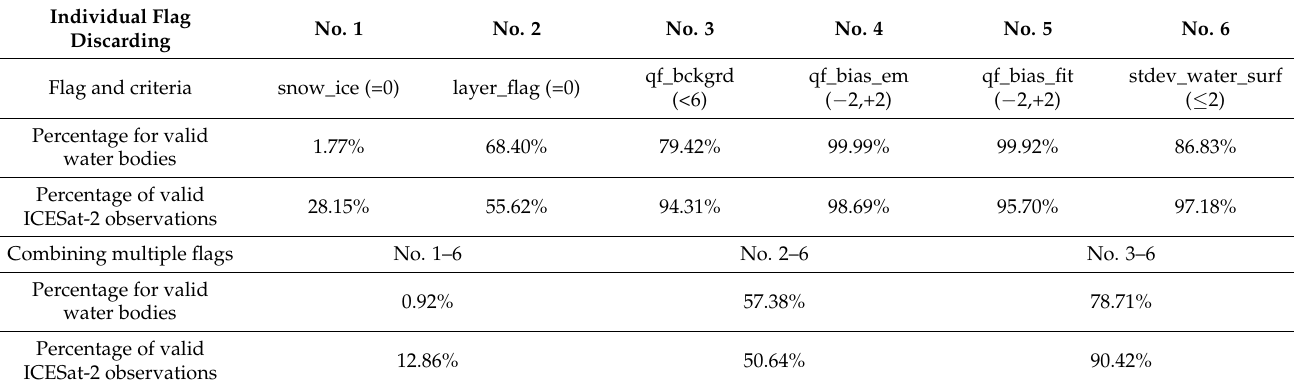
Table 1. Statistics of the valid data when using different data quality flags from ATL13 products. The percentage of valid observations represents that, after the flag discarding, the number of valid observations occupies the specific proportion in all ICESat-2 ATL13 observations. The percentage of valid water bodies represents that, after the flag discarding, the number of water bodies that have valid ICESat-2 observations occupies the specific proportion in the 753,495 water bodies that are covered by ICESat-2 ATL13 observations. After discarding poor-quality data, the percentages of valid water bodies are different from the percentages of ICESat-2 valid observations because large water bodies occupy many more surface observations than the smaller